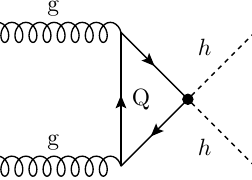
Figure 2 . Feynman diagrams for the ggF process of Higgs pair production in the SM.